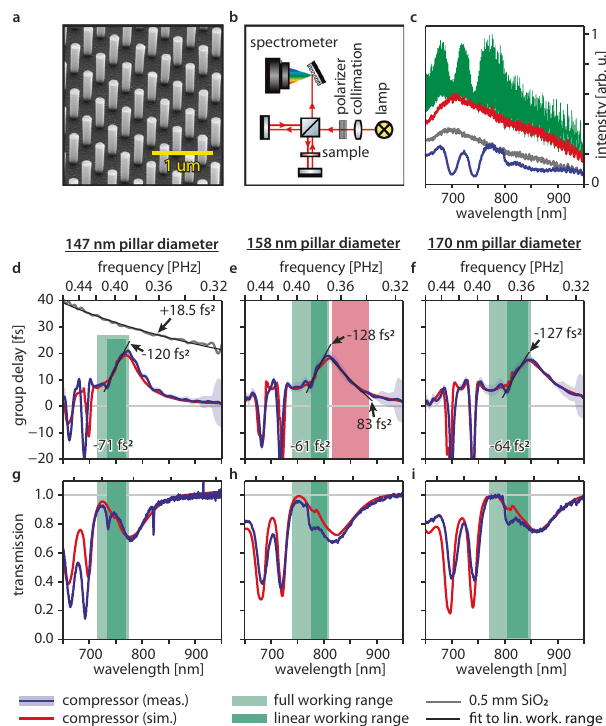
Fig. 3 White-light interferometry of compressors designed for different operating wavelengths. Samples are labeled by the nanopillar diameter. a Scanning electron microscope picture of the compressor with 158 nm nanopillar diameter. b White-light interferometer setup. Thermal radiation from a tungsten lamp (red lines) is collimated, polarized, and then split in a Michelson interferometer. Light in one interferometer arm passes the sample twice, light in the other arm is delayed. The variable delay between the two arms causes spectral intensity oscillations associated with the compressor group delay dispersion that are recorded by a grating spectrometer. c Example of white-light interferometer raw data for the sample with 170nm nanopillar diameter. Interference spectrum (green); spectrum transmitted by the compressor when the reference arm is blocked (blue) and when the compressor sample is replaced by a fused silica substrate and the reference arm is blocked (gray); the spectrum of the lamp, when the sample arm is blocked (red). d – f Compressor group delay pro fi le measured by white-light interferometry (blue lines). FDTD simulations (red lines) account for 4 nm nanopillar diameter fabrication tolerance. The black lines are linear fi ts to the measured group delay pro fi les in the linear working ranges (dark green areas) and are labeled with their group delay dispersion (slope). The average group delay dispersions in the full working ranges (light green areas) are also indicated. The red area in e marks the spectral region in which the compressor coating imprints positive group delay dispersion. The measured group delay pro fi le of the fused silica substrate (gray line) and a fi t to it (black line) are shown for reference. Both were shifted vertically to fi t the plotting region. The blue-shaded areas represent the measurement uncertainty: to retrieve an upper bound for the systematic error, we compare a reference measurement on the fused silica substrate with its literature group delay pro fi le. We then use the maximum deviation of the two in a 50nm bandwidth around each wavelength point as uncertainty and add the standard deviation. g – i Measured (blue lines) and simulated (red lines) compressor transmission characteristics relative to the fused silica substrate